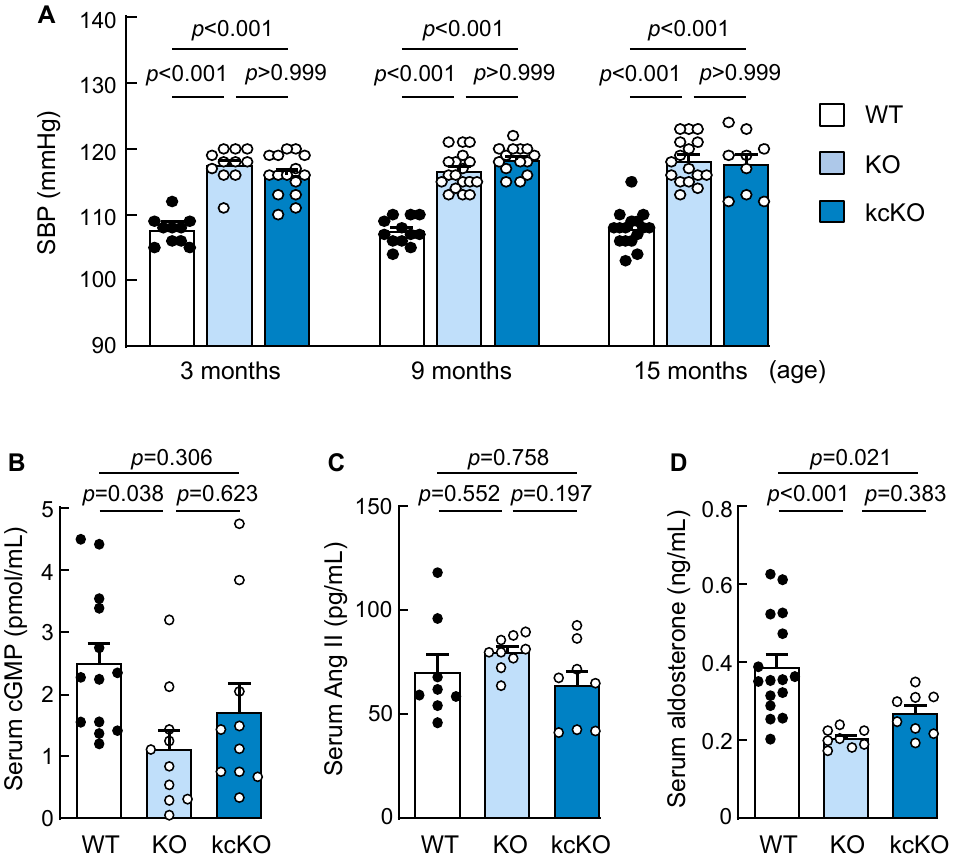
Figure 2. Hypertension in corin kcKO mice. ( A ) Systolic blood pressure (SBP) in male WT (black dots), corin KO, and kcKO (white dots) mice at 3, 9, and 15 months of age ( n = 9–18). ( B – D ) Levels of serum cGMP ( B ), angiotensin II (Ang II) ( C ), and aldosterone ( D ) from male WT (black dots), corin KO, and kcKO (white dots) mice were measured by ELISA ( B , D ) or enzyme immunoassay ( C ). n = 8–16 per group. Data presented are mean ± SEM. P -values were analyzed by one-way ANOVA.